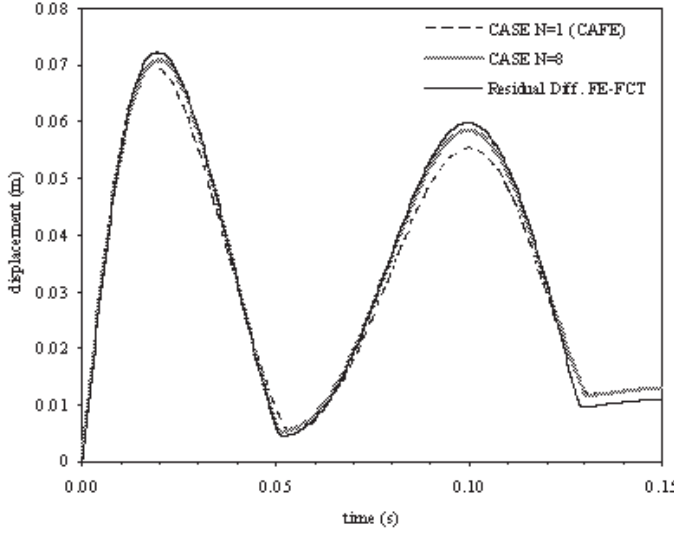
Fig. 9. Results for the displacement of m 1 using 41 fluid DOF.